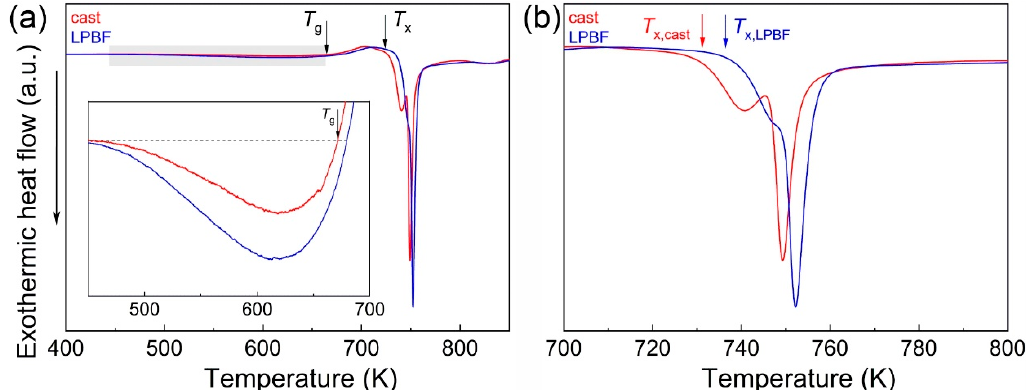
Figure 3. Isochronal DSC curves (heating rate 20 K/min) for the Zr 52.5 Ti 5 Cu 18 Ni 14.5 Al 10 BMGs fabricated by casting and LPBF. ( a ) The grey area indicates the temperature range where structural relaxation takes place. T g and T x mark the temperatures of glass transition and crystallization. Inset: magnified segment of the DSC curve highlighting the effect of structural relaxation. ( b ) Magnified temperature section in which crystallization occurs. The crystallization onset temperature of the LPBF-BMG sample is higher, most likely due to the higher oxygen content.